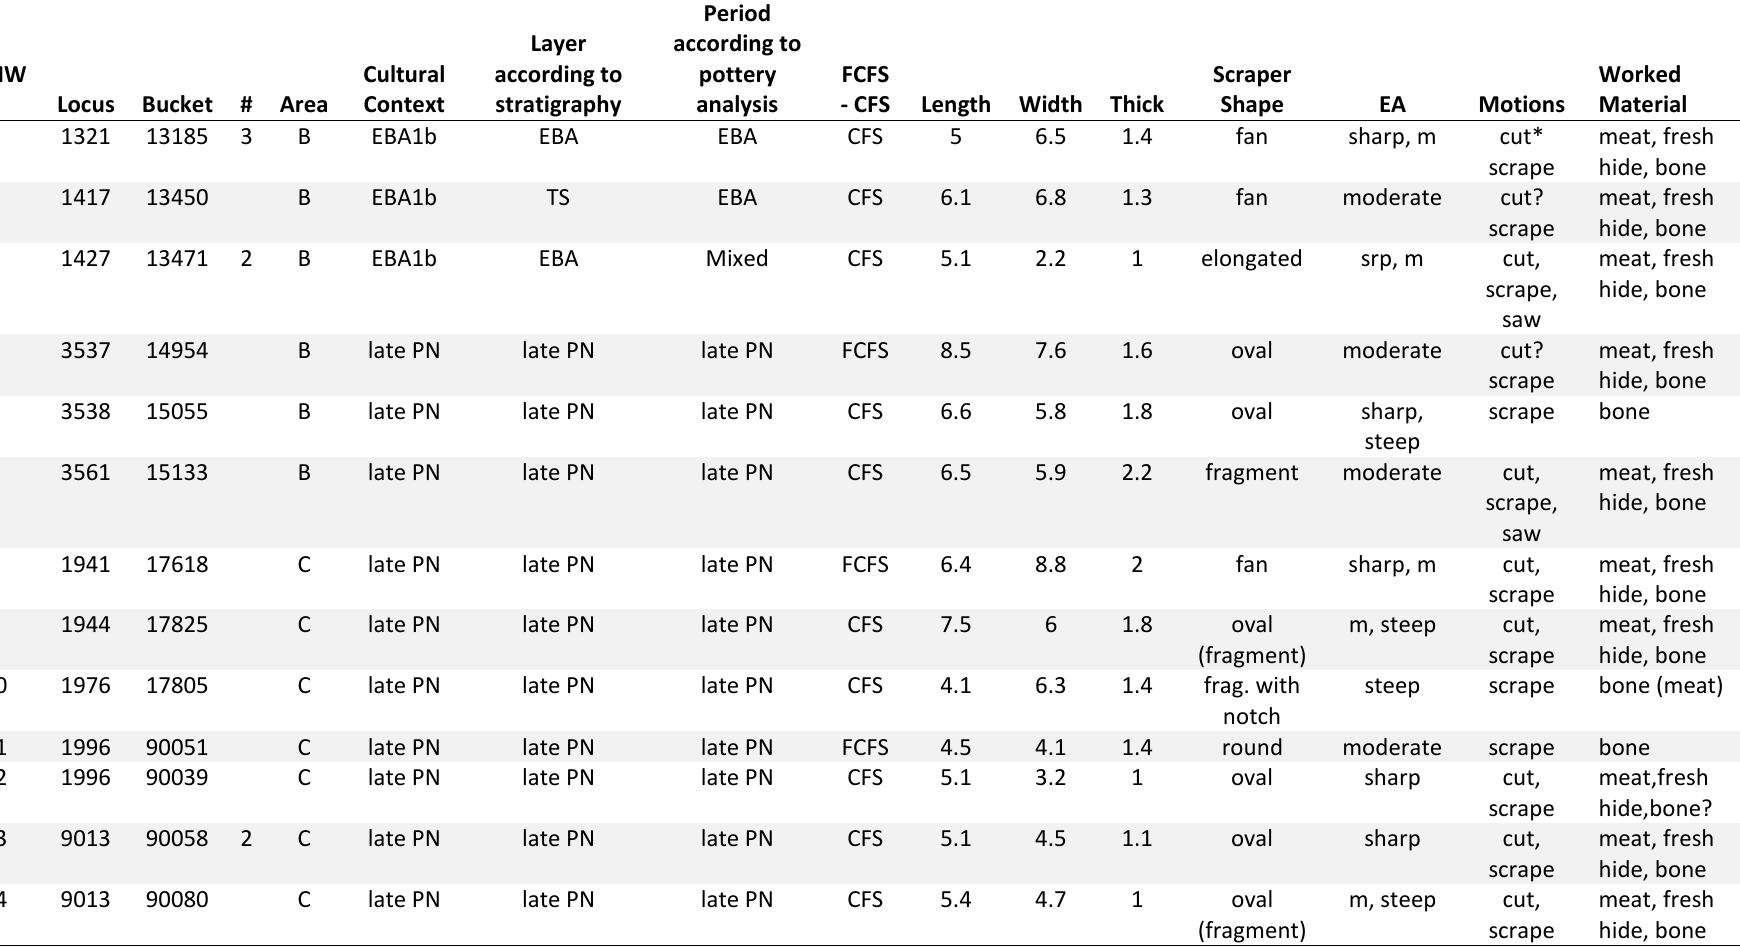
Table 1. Ein Zippori fan scrapers microwear results. Abbreviations: Loc. = Locus, Buck. = Bucket; late PN = late Pottery Neolithic Wadi Rabbah, EBA = Early Bronze Age1b, cultural period based on stratigraphy and pottery analysis, TS = mixed surface; FCFS = flat cortex fan scraper with flat dorsal face, CFS = cortical fan scraper with convex dorsal face; GL = greatest length, GW = greatest width, Th = thickness in mm; elong. = elongated, frag. = fragment, irreg. = irregular shapes; m = moderate, srp = sharp, stp = steep